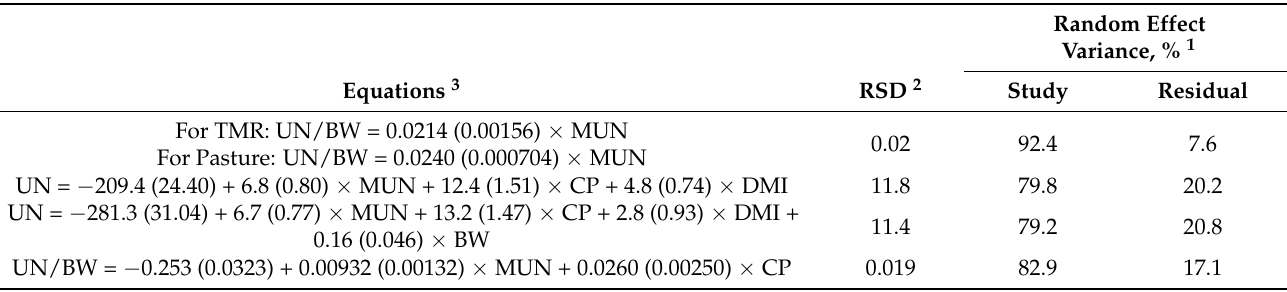
Table 4. Developed equations to predict urinary nitrogen (g/d; UN) or UN per kg of body weight (kg; BW) as a function of milk urea nitrogen (MUN; mg/dL) only, dietary crude protein (%; CP), dry matter intake (kg; DMI), or BW from cows fed a total mixed ration (TMR) or fresh forage diet (Pasture).